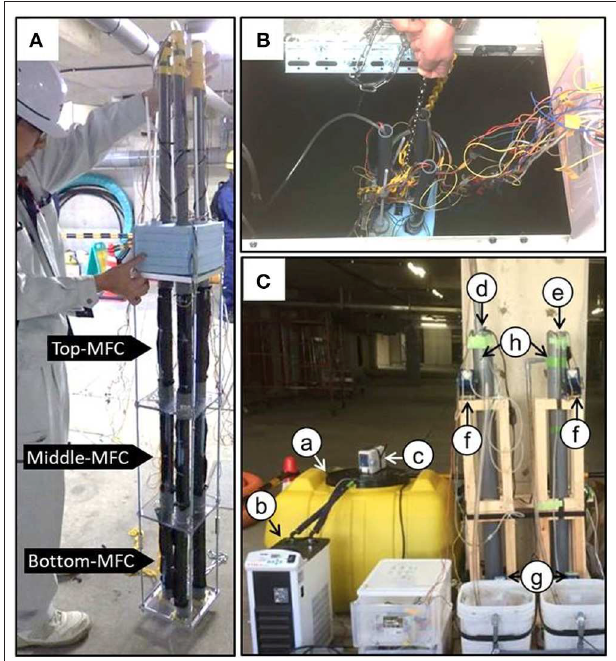
FIGURE 1 | The modularized microbial fuel cells used in this study (A) and the MFC modules floating in the sewage water channel (B) and chemostat reactors (C) . In (C) , the letters indicate the following components: (a) influent storage tank, (b) cooling water circulating system, (c) impeller for mixing the influent, (d) reactor with the MFC, (e) reactor without the MFC (NON), (f) circulation pump, (g) feeding pump, and (h) effluent outlet. The effluent was sampled from the outlet (h) to determine the COD concentration. The influent was also partially collected from the tube that connected the storage tank (a) to the reactors